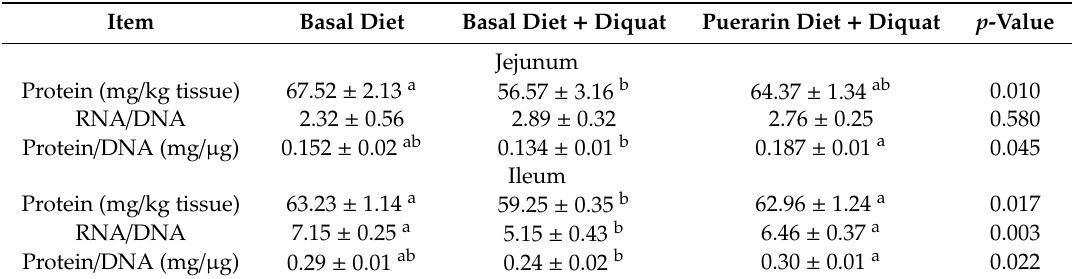
Table 4. E ff ects of dietary puerarin supplementation on the protein, DNA and RNA contents in the jejunal and ileal mucosa of the